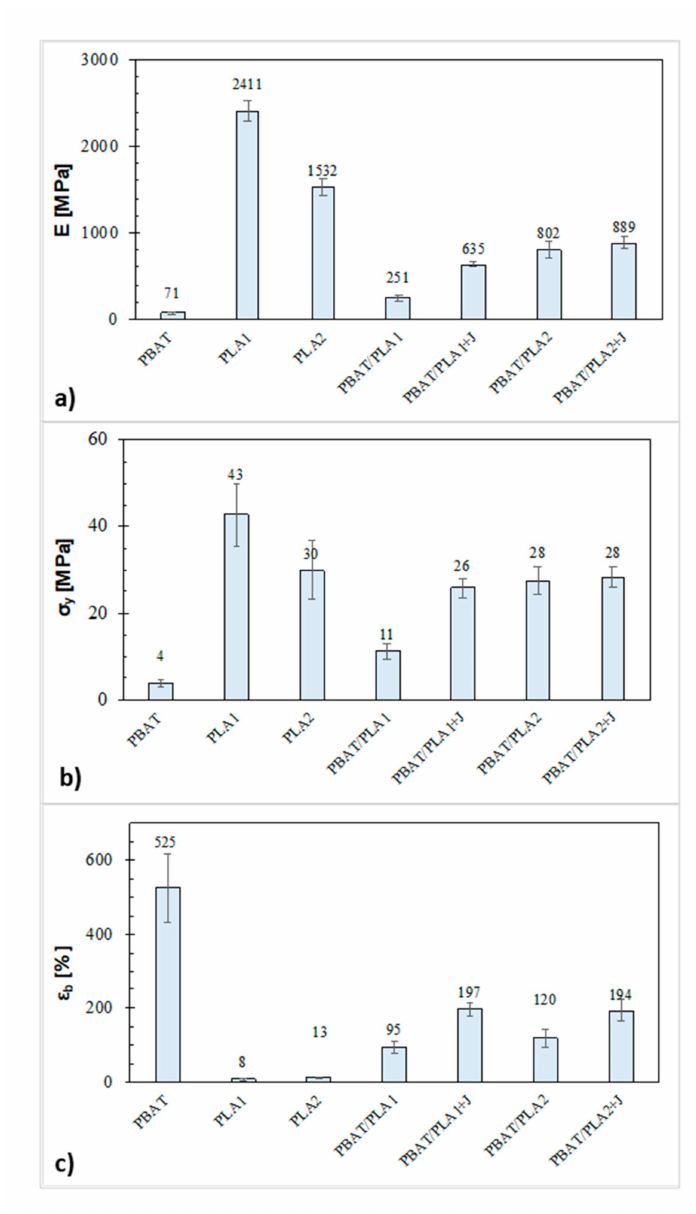
Figure 6. ( a ) Elastic modulus, ( b ) yield stress, and ( c ) elongation at break of the